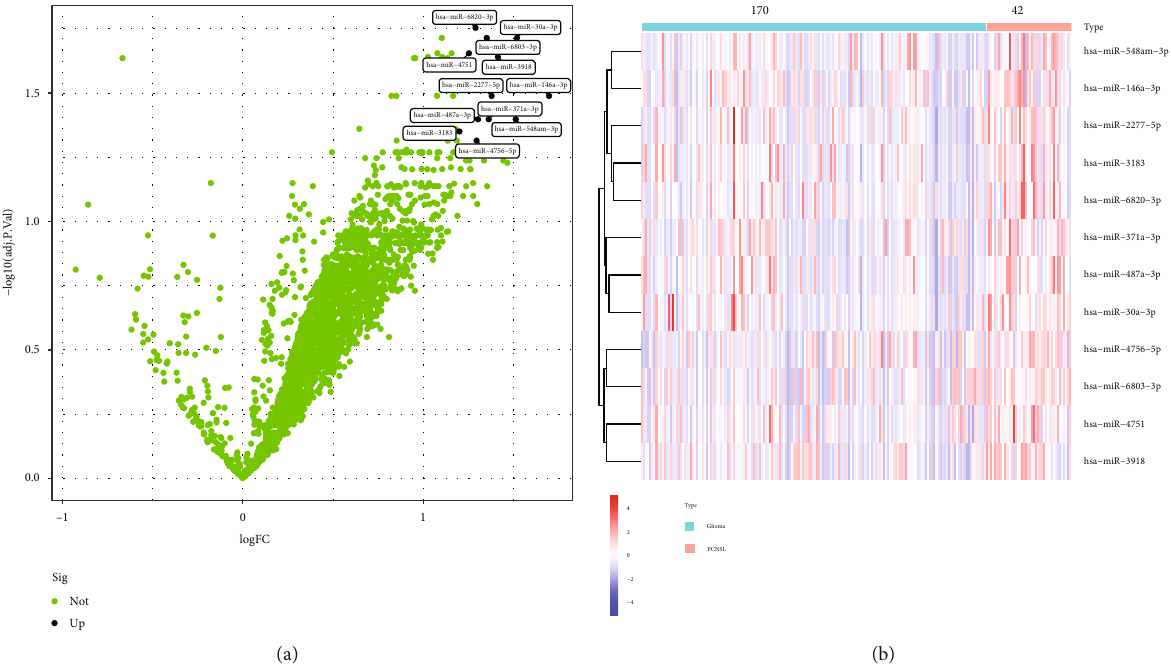
Figure 1: Volcano plot (a) and heat map (b) showed the di ff erentially expressed miRNAs between PCNSL and glioma specimens.